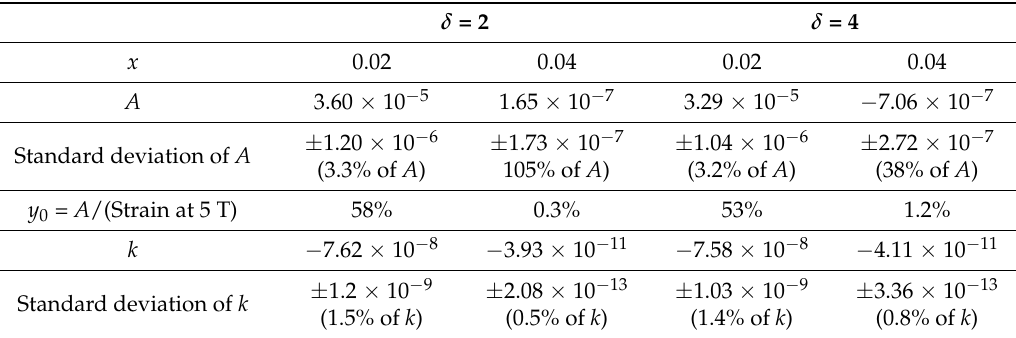
Figure 7. The M 4 dependence of magnetostriction for ( a ) x = 0.02 and ( b ) x = 0.04. The dotted straight lines are included as a visual guide. Table 3. The coefficients and standard deviations of the linear fitted plots obtained by means of the least squares method at T C for the magnetostriction ∆ L / L by the equation ∆ L / L = A + kM δ for δ = 2 or 4, as shown in Figures 5 and 6, respectively. Both A and k are constants.